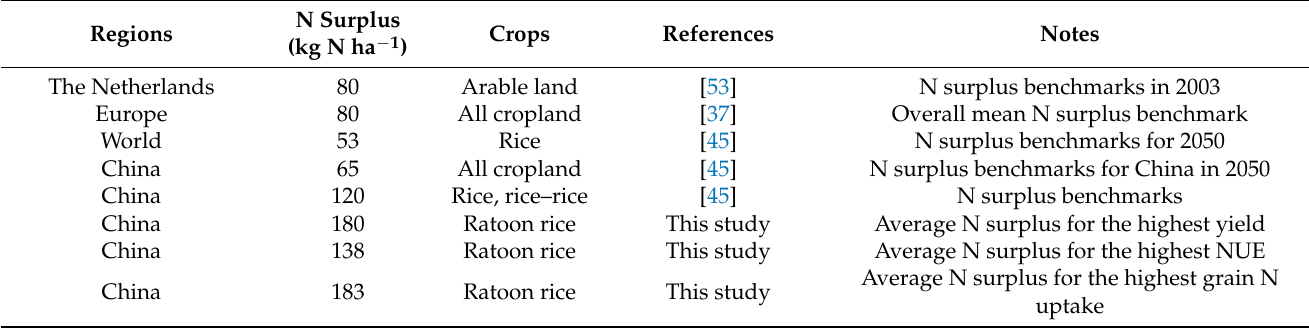
Table 3. Comparison of N surplus benchmarks between China and other